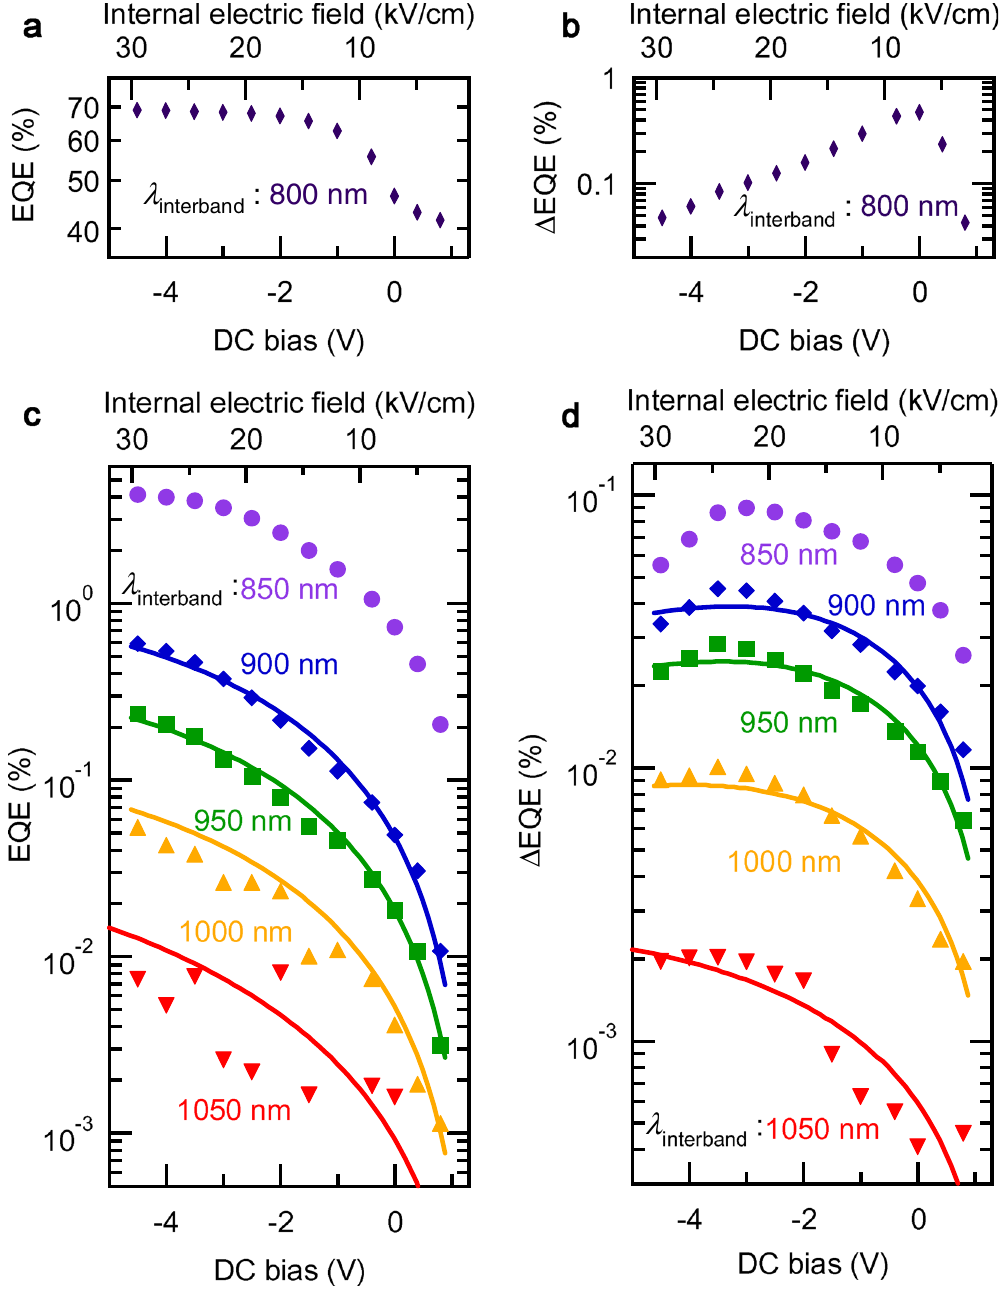
Figure 3. DC-bias dependence of the EQE and Δ EQE signal intensities detected at several wavelengths of the first interband excitation. ( a ) EQE and ( b ) Δ EQE at 800 nm as a function of the internal electric field. ( c ) EQE and ( d ) Δ EQE represent the results at 850, 900, 950, 1,000, and 1,050 nm. These data are taken at 9